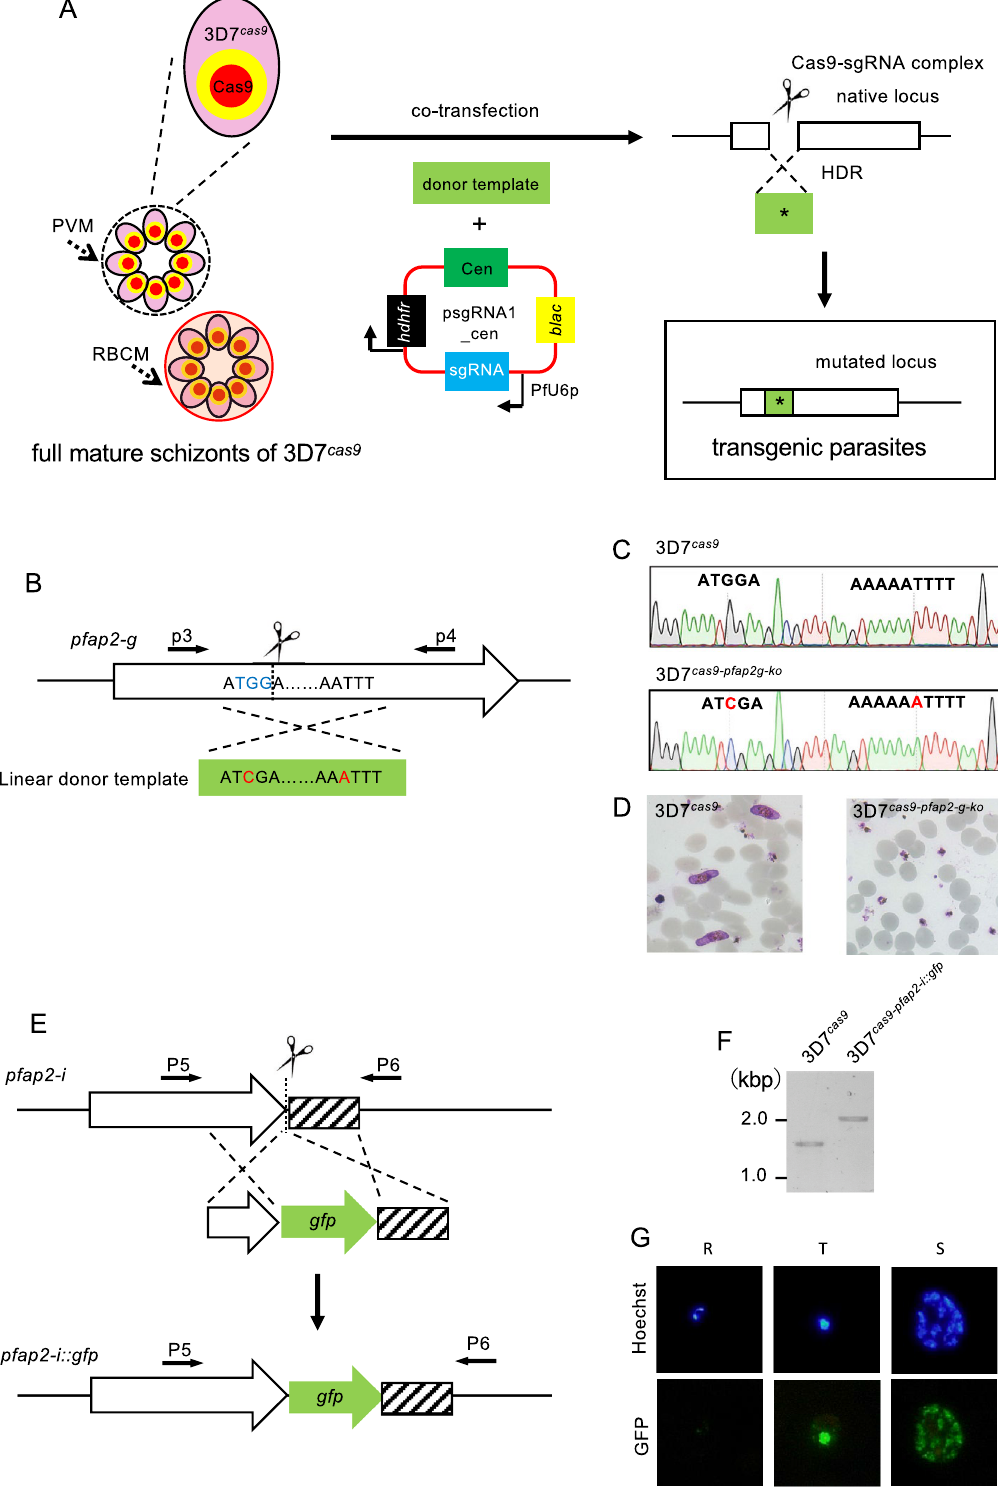
Figure 3. Genetic engineering using 3D7 cas9 . ( A ) To engineer the gene, 3D7 cas9 was co-transfected with the linear form of donor template DNA and psgRNA1_cen containing the sgRNA. The targeted genomic locus was cleaved by the Cas9-sgRNA complex, followed by HDR with the donor template. ( B ) pfap2-g was disrupted by insertion of a single adenosine in the open reading frame. The PAM sequence TGG was also mutated by substitution from guanosine to cytosine. ( C ) The mutations introduced in pfap2-g were confirmed by sequencing. Red indicates the mutation. ( D ) The 3D7 cas9-pfap2-g-ko parasite completely lacks gametocyte production. ( E ) The gfp gene was integrated at the C-terminus of PfAP2-I. ( F ) Genotyping PCR of 3D7 cas9-pfap2-i::gfp parasites was performed using the p5 and p6 primers to examine the integration of gfp . Full length gel image is included Fig. S4D. ( G ) PfAP2-I-GFP expression in 3D7 cas9-pfap2-i::gfp was uniquely confirmed in trophozoite (T) and schizont (S), not in ring form